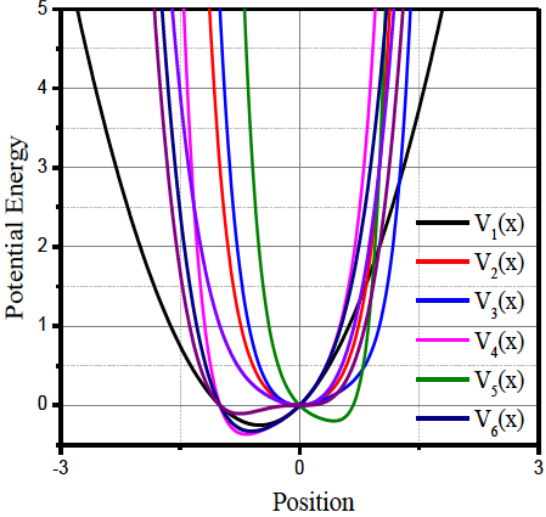
Figure 1: Studied potentials energy